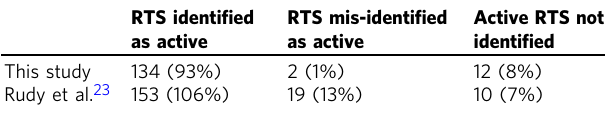
Table 1 Error matrix for identi fi cation of active